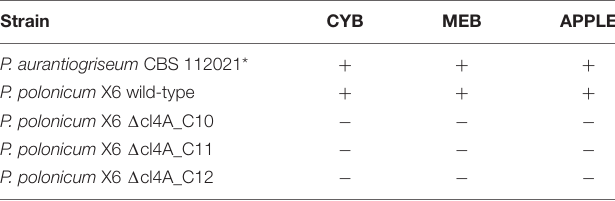
TABLE 1 | Effect of gene deletion on verrucosidin production in vitro and in vivo. Strain CYB MEB APPLE